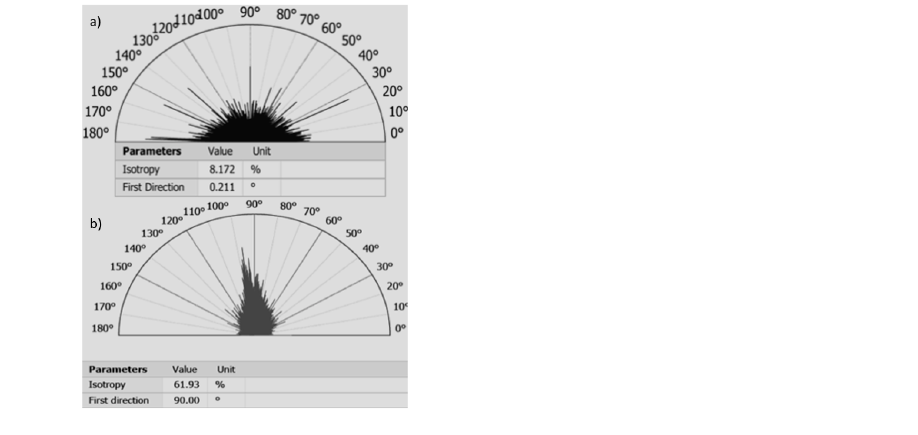
Figure 13. Isotropy chart before ( a ) and after ( b ) Stream Finishing process parameters optimization.